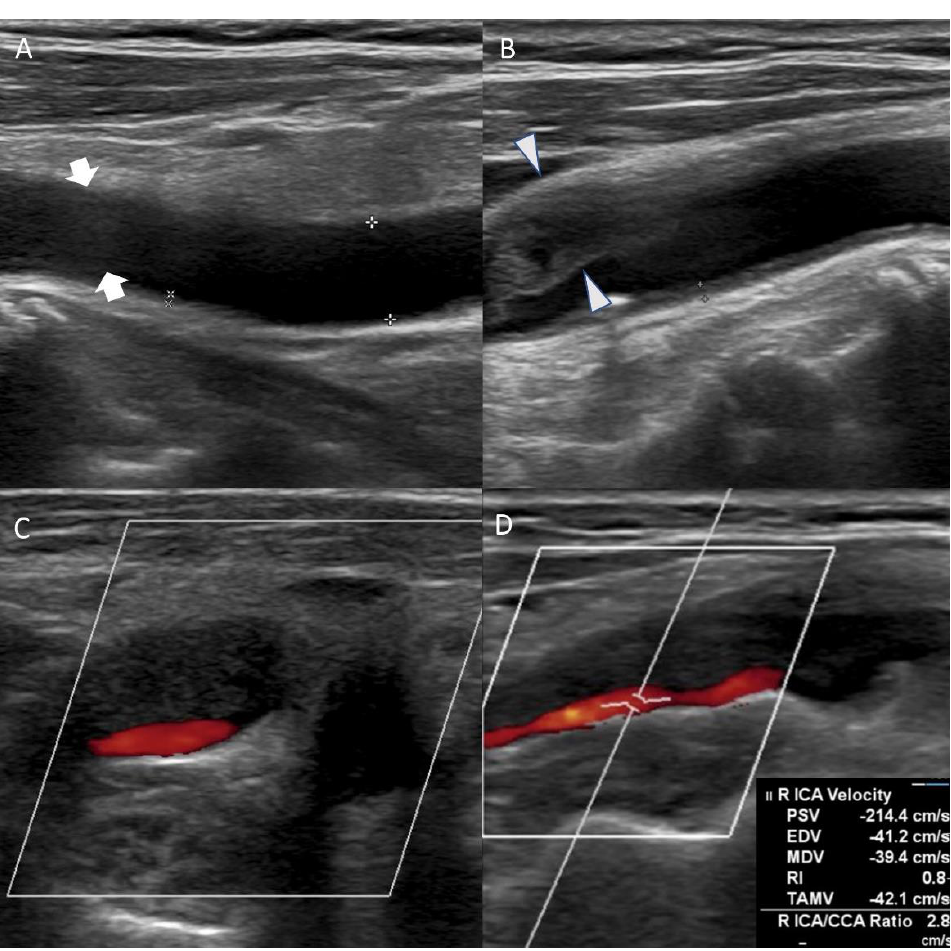
Figure 2. Carotid duplex ultrasonography conducted on the eleventh day of hospitalization showed echolucent (hypoechoic) plaque of right common carotid artery ( A , arrow) and extensive stenosis of right carotid artery bulb ( B , arrowhead). Axial view of the carotid artery bulb presented heterogeneous plaque suggesting lipid and calcification ( C ). Echolucent (hypoechoic) plaque that occluded right proximal internal carotid artery was observed, and peak systolic velocity of the internal carotid artery (ICA) stenosis site was 214.4 cm/s ( D ).